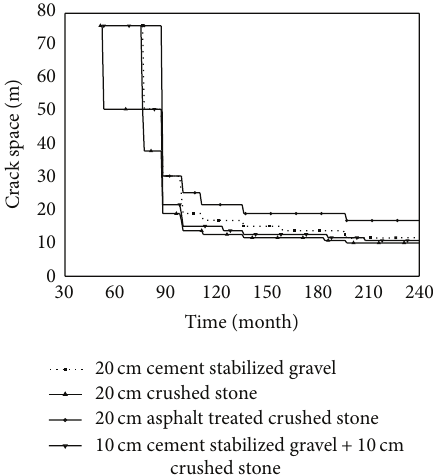
Figure 2: Influence of asphalt surface layer thickness on thermal cracking space on asphalt pavement.